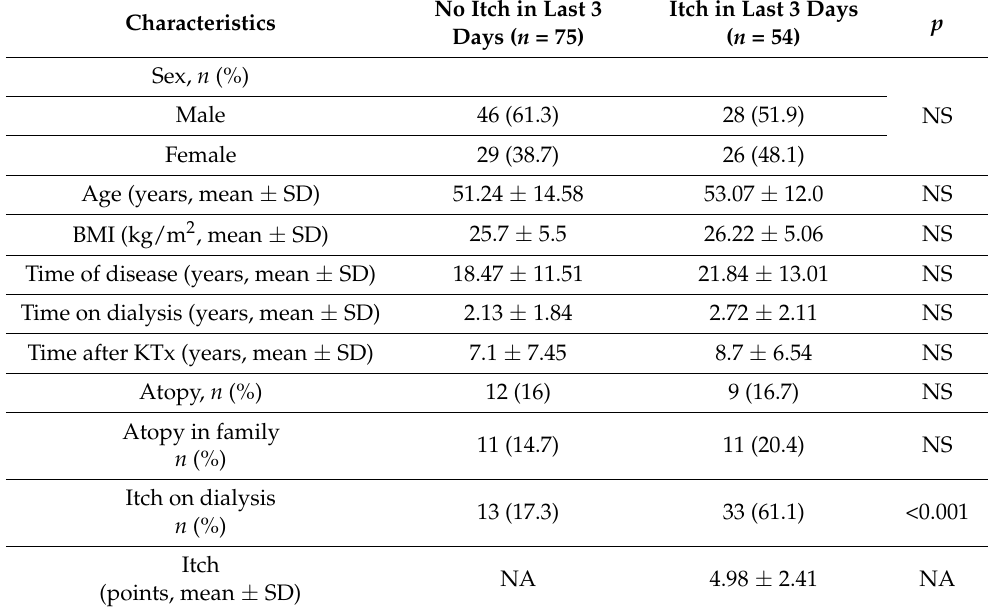
Table 1. Patients’ demographics.